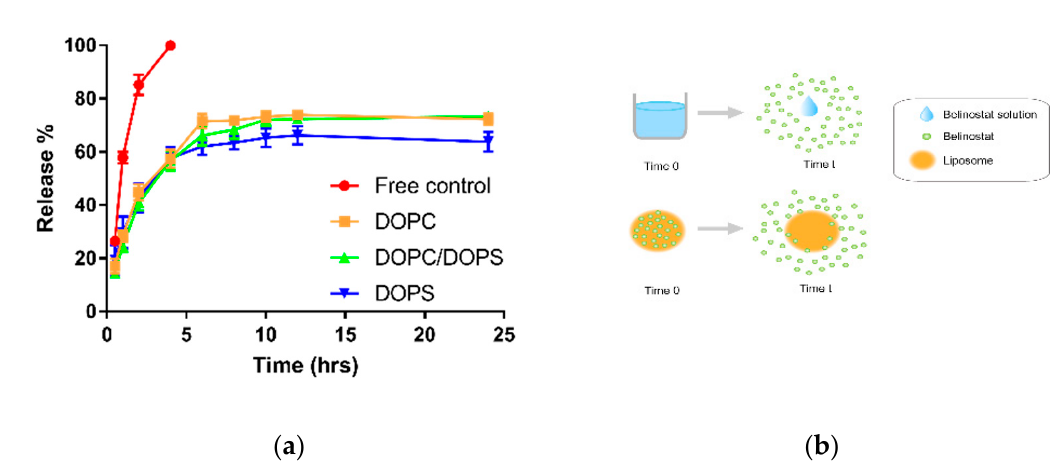
Figure 3. Drug release profiles and prediction by mathematical models to investigate the release mechanism. ( a ) In vitro release profile of free belinostat and belinostat-loaded liposomes obtained using the dialysis method. ( b ) Schematic diagram of belinostat release mechanism from the liposomal particulate system. Note: Belinostat was dissolved in absolute ethanol in the control group. Data are presented as mean ± standard deviation ( n = 3). Table 2. Comparison of suitable release pattern obtained from fitting experimental data with five models.